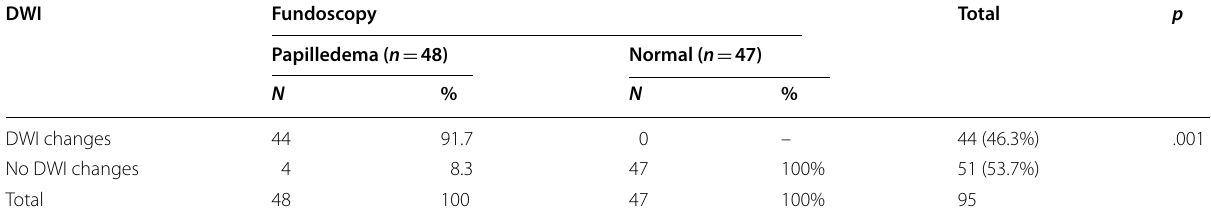
Table 8 Association of DWI with fundoscopy in evaluation of papilledema in group (A) DWI